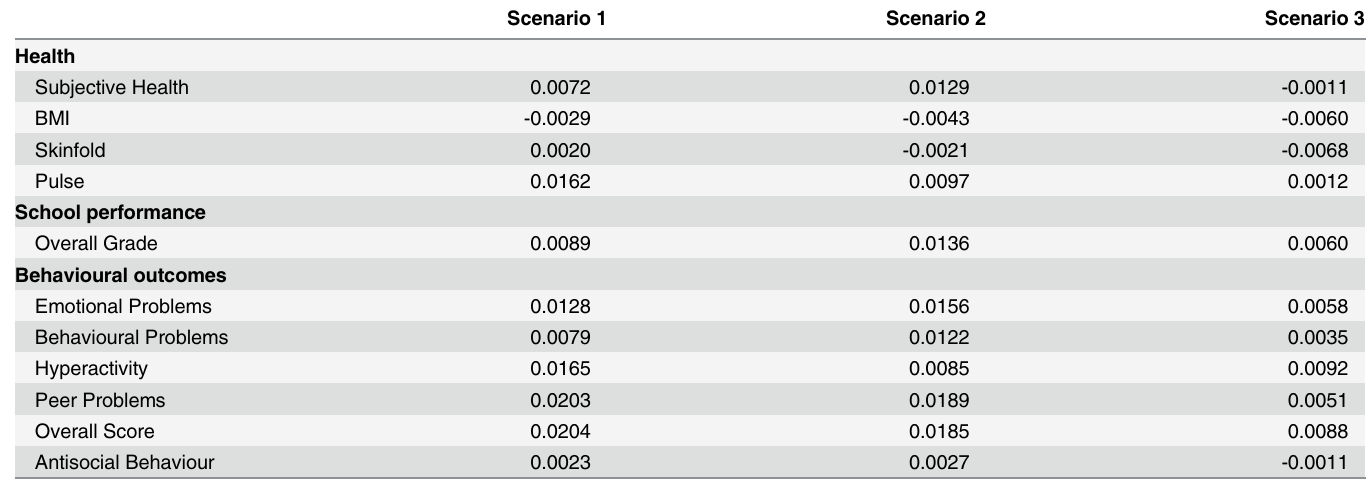
Table 5. Sensitivity check — Difference of effects under different confounding scenarios relative to the baseline scenario (ATE). Note: Each cells shows the difference in the effects resulting from an alternative confounding scenario to the baseline scenario. Scenarios 1 – 3 simulate the new confounding variable mimicking the relation of three important confounders to treatment and outcome, respectively (scenario 2 mimics the relation to family income > 5000 Euro; scenario 3 mimics the relation to mom ’ s education degree being university, scenario 4 mimics the relation to the local employment rate). Inference is based on 99 bootstrap replications and 19 draws of simulated binary confounder; quantile method, smoothed version, linear / logistic bias adjustment, sym- metric p-values used. None of the differences is significant at the 10%